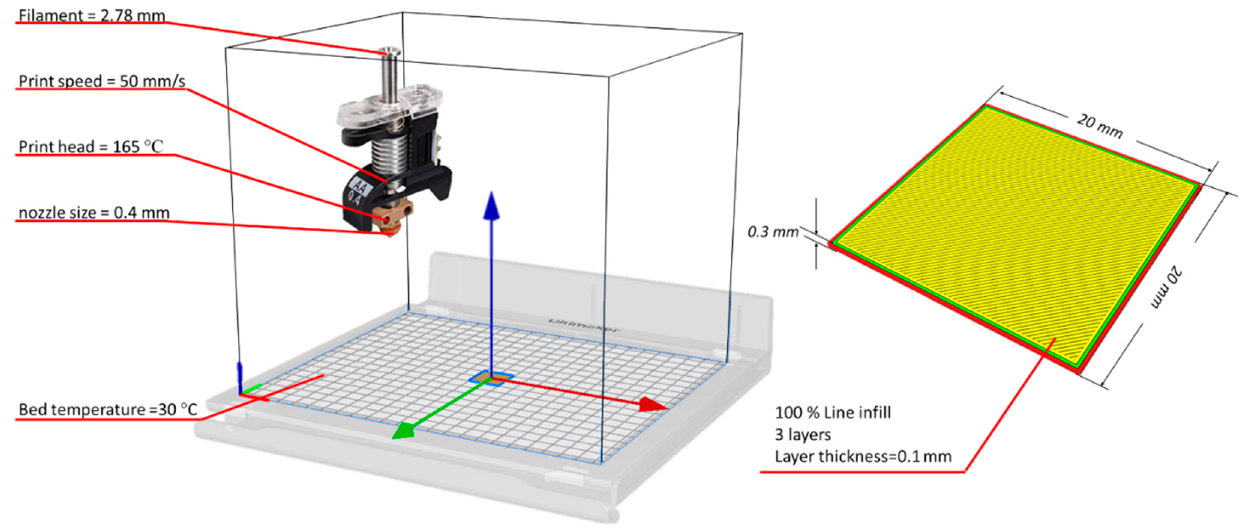
Figure 2. The printing process parameters and the film 3D design.